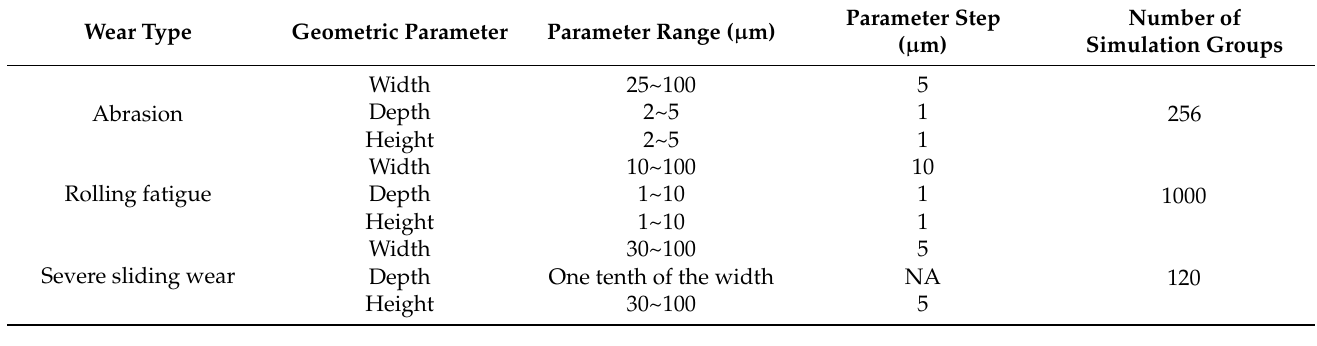
Figure 9. Simulation example diagram of three types of wear particles. ( a ) Abrasion; ( b ) Rolling fatigue; ( c ) Severe sliding wear.